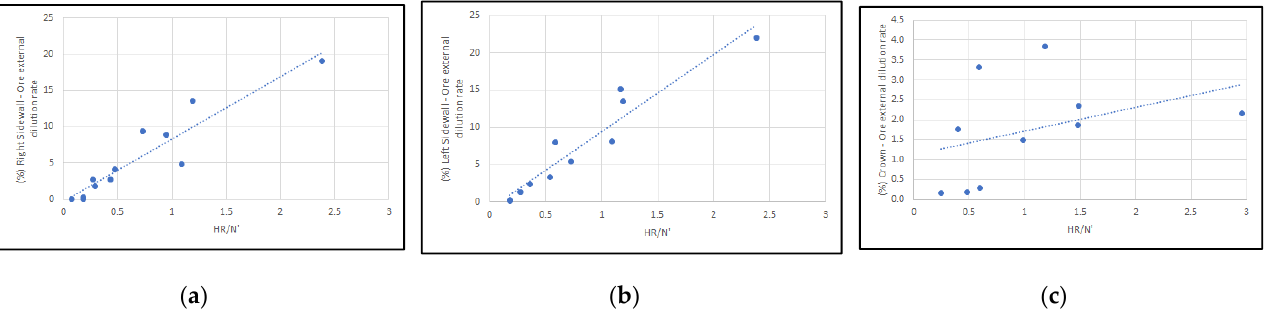
Figure 2. (%) ore external dilution rate—HR/N’ diagrams: ( a ) right sidewall (HW); ( b ) left sidewall (FW); ( c ) crown.